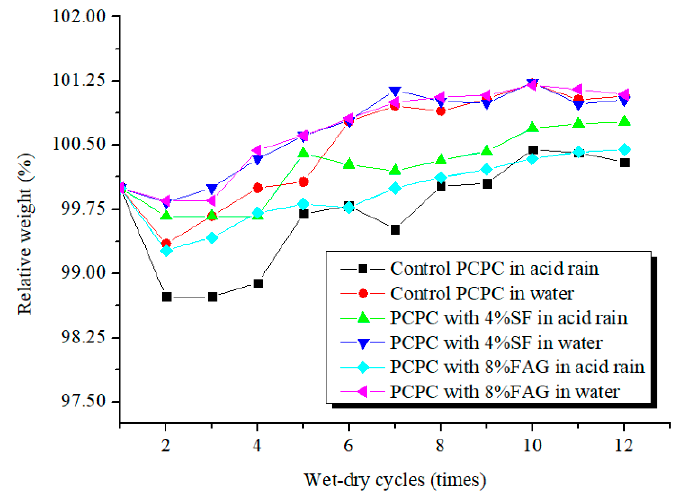
Figure 2. The relative weight of PCPC with wet-dry cycles.